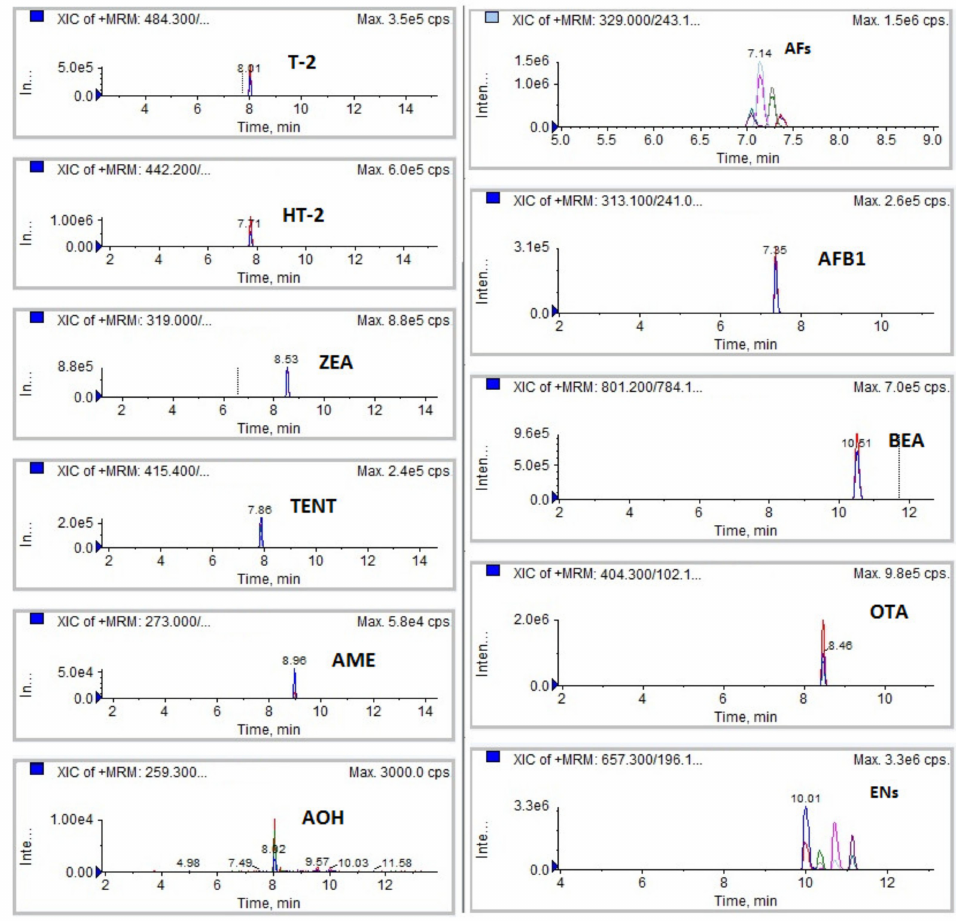
Figure 1. Chromatograms of a standard solution containing the 16 mycotoxins analyzed by